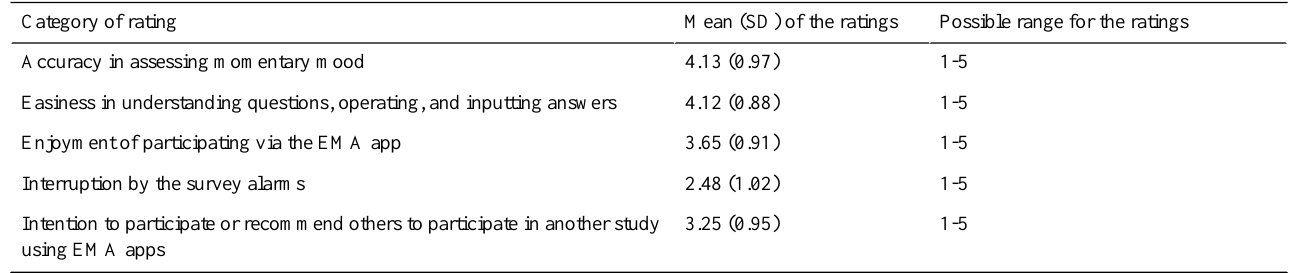
Table 5. Usability of the EMA a method by using a mobile app